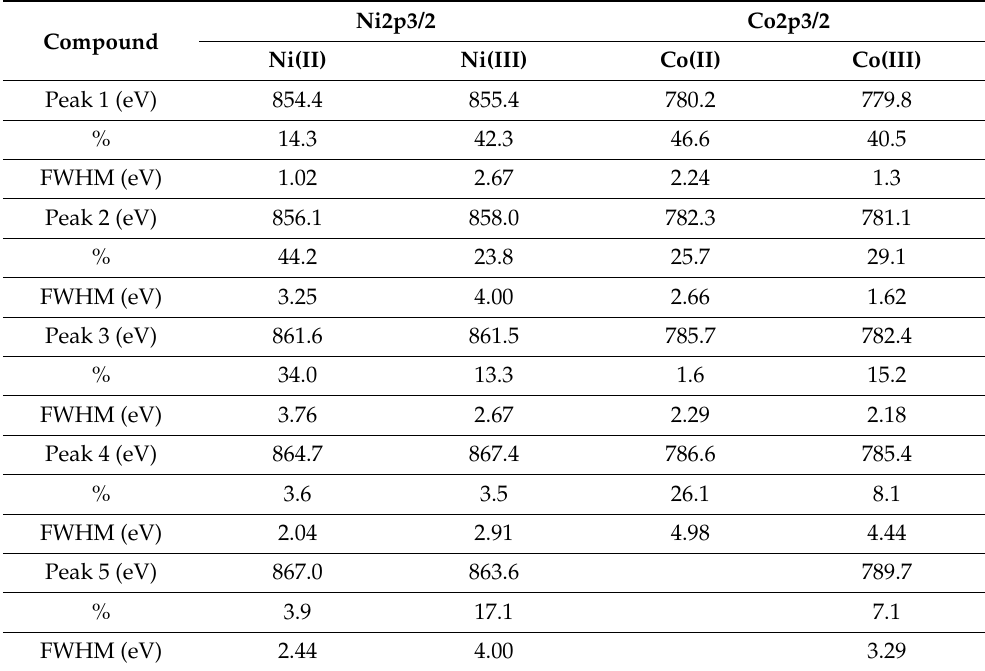
Table 2. Coupling parameters of the Ni2p3/2 and Co2p3/2 spectra with determination of the states: binding energy (eV), percentage of the total area, FWHM (eV).